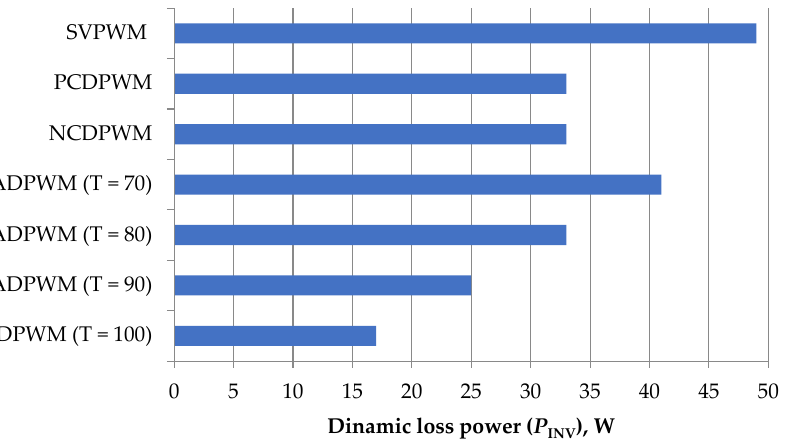
Figure 10. Dynamic losses in the inverter switches dependence for the proposed ADPWM method and other PWM strategies.